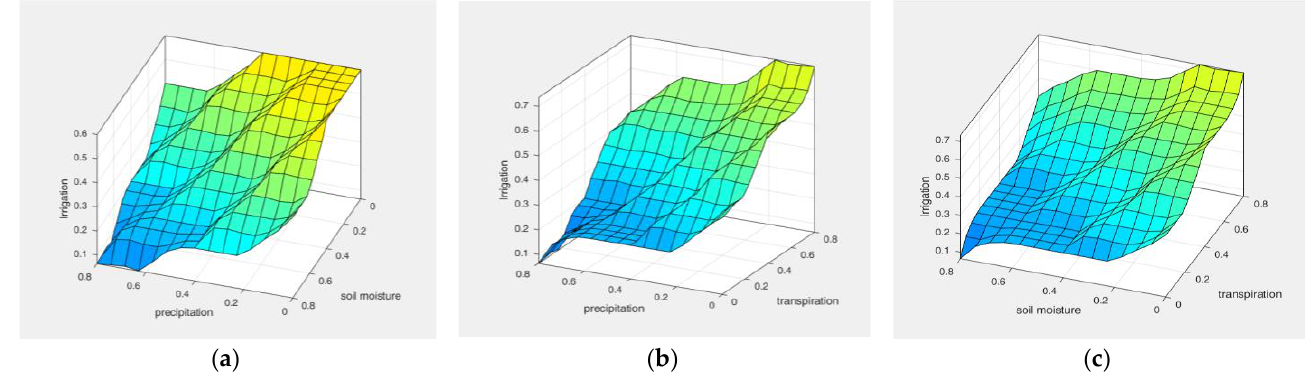
Figure 12. Fuzzy algorithm rule variable relationship diagram: ( a ) rainfall — soil moisture — irriga- tion; ( b ) rainfall — evapotranspiration — irrigation; and ( c ) soil moisture — transpiration — irrigation. Table 4. Fuzzy rules.